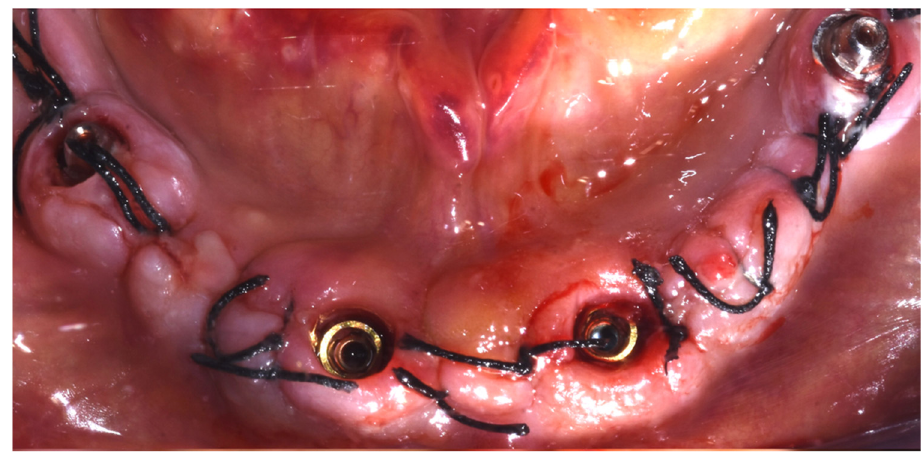
Figure 10. Soft tissue healing after 48